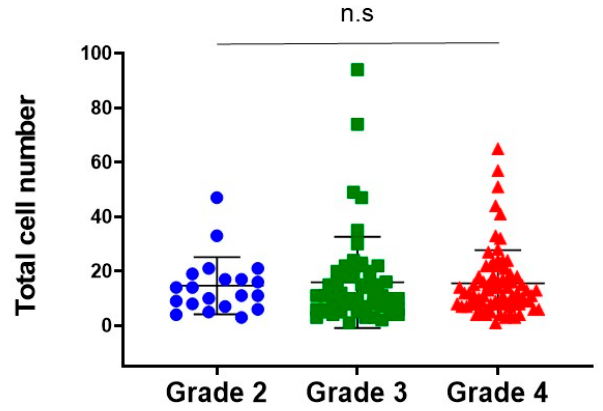
Figure 4. Total cell number by MRI grade classification. n.s not significant.